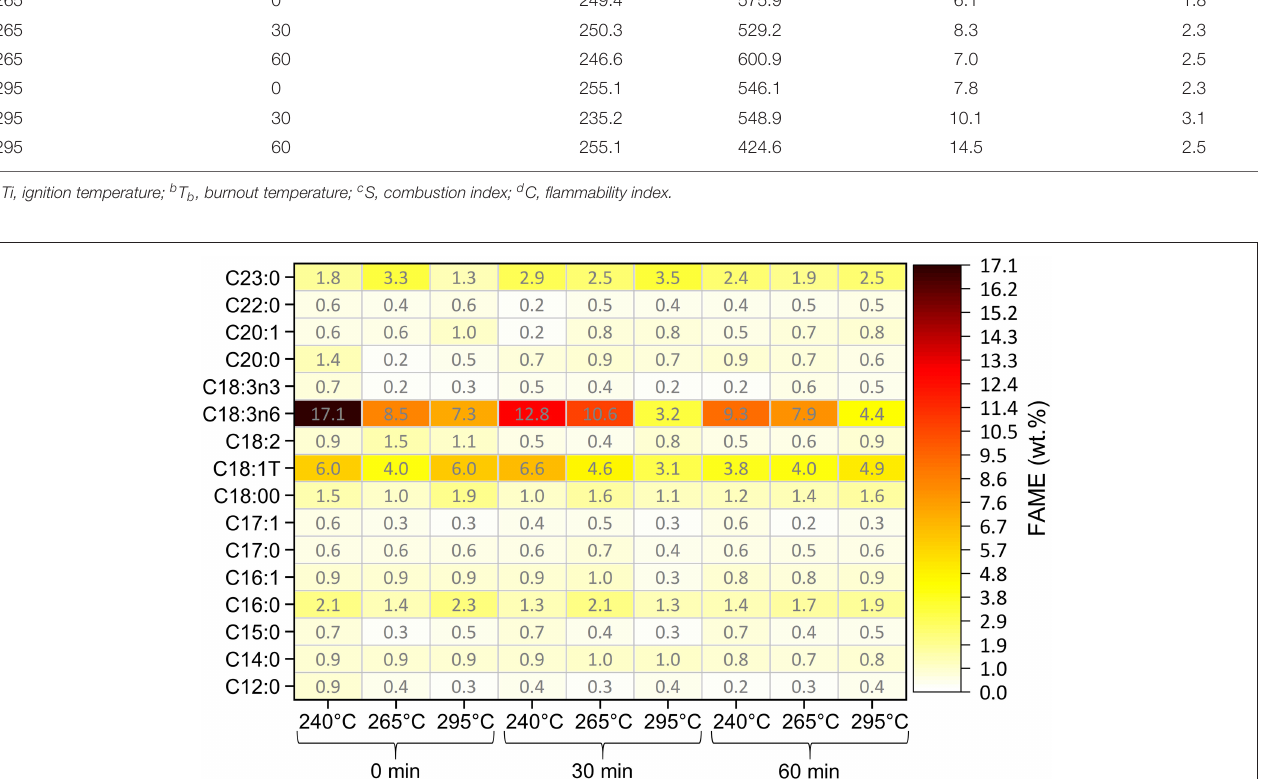
increases bio-crude oil viscosity and acid value, reducing HHV and requiring further